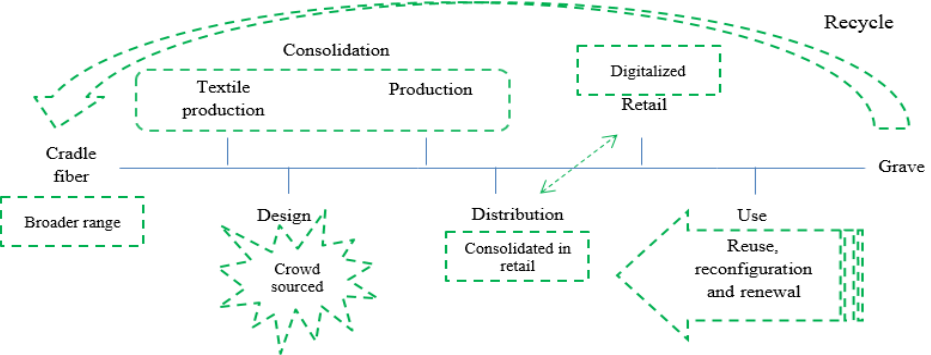
Figure 2. The potential changes posed by direct digital manufacturing to the clothing lifecycle [101,104].